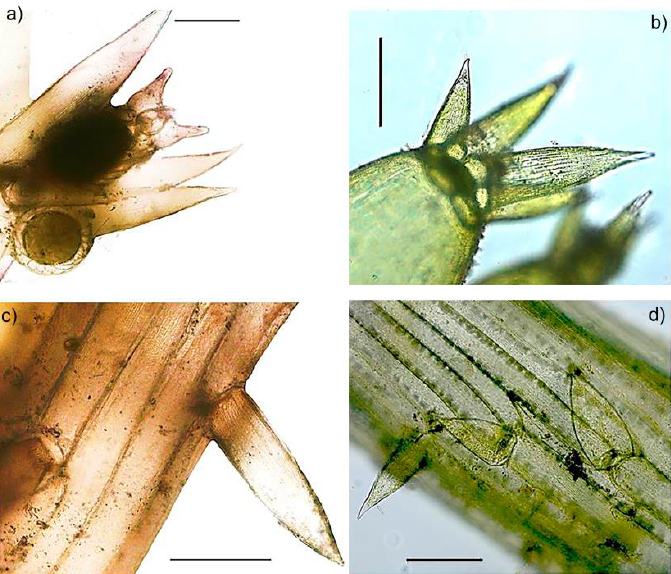
Figure 1. Macro habitus, scale 5 cm.